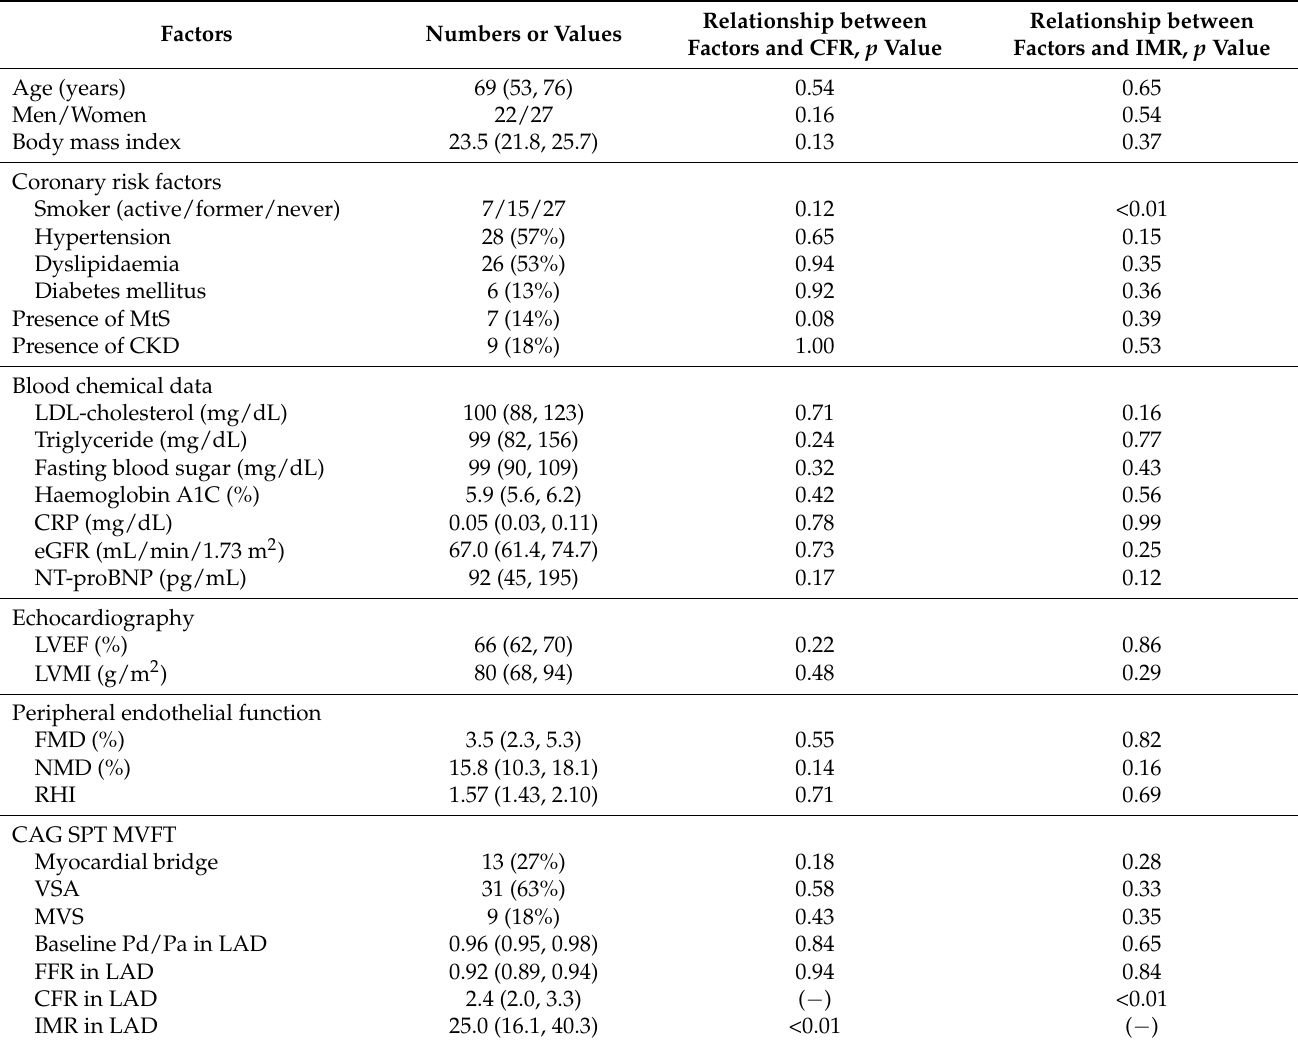
Table 1. Patients’ characteristics of 49 patients who had MVFT in